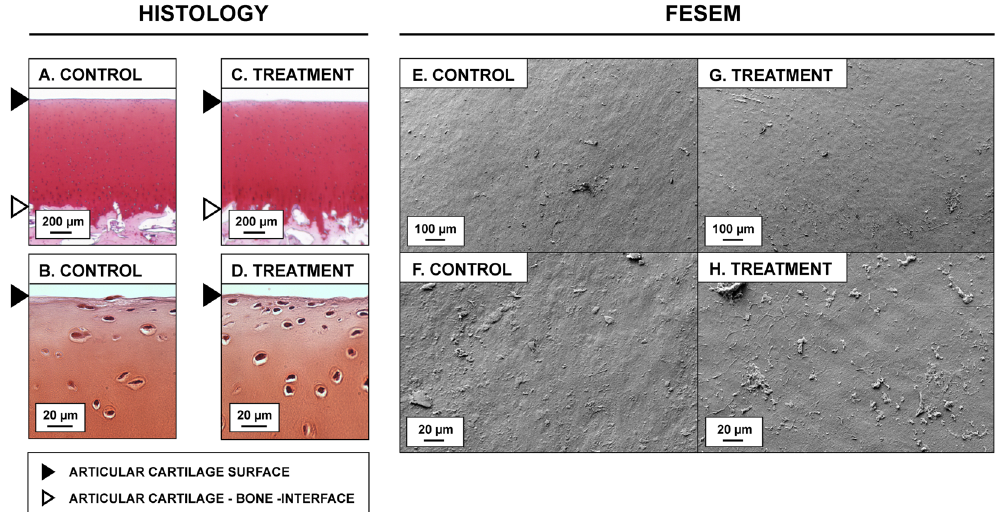
Figure 5. Damage assessment. No differences in superficial fibrillation or in fixed charge density (red contrast, binds stoichiometrically to proteoglycan) were observed in safranin O -stained articular cartilage (AC) control sections ( A , B ), Control, ( n = 6) as compared to sections from adjacent AC tissue exposed to laser-ultrasound (LU) ( C , D ), treatment, ( n = 6). Similarly, field emission scanning electron imaging (FESEM) assessment did reveal no structural damage to the AC surface when comparing control samples ( E , F ), ( n = 6) to treatment samples ( G , H ), ( n = 6). These results suggest that LU applied in this study does neither cause structural damage to AC surface, which is rich in collagen, nor induce proteoglycan